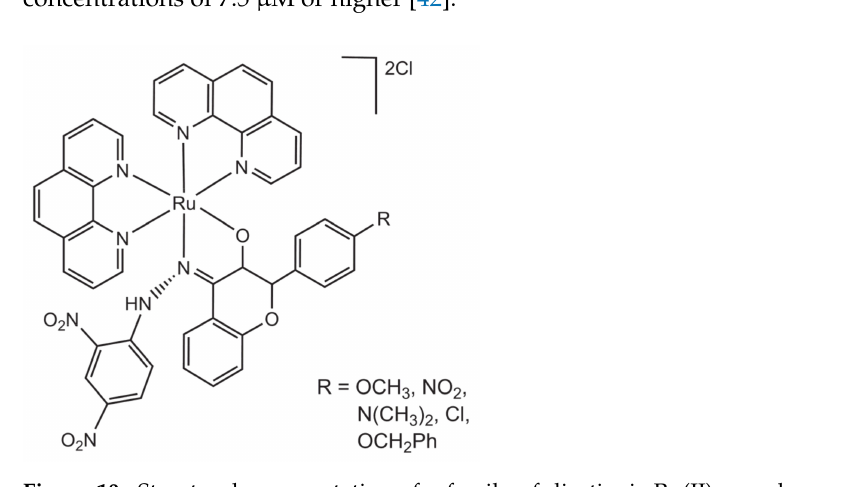
Figure 10. Structural representation of a family of dicationic Ru(II) complexes with the ligands 1,10-phenanthroline and hydrazine-flavone: [Ru(3-OH-4-hydrazine-4 (cid:48) -R-flavone)(phen) 2 ]PF 6 .